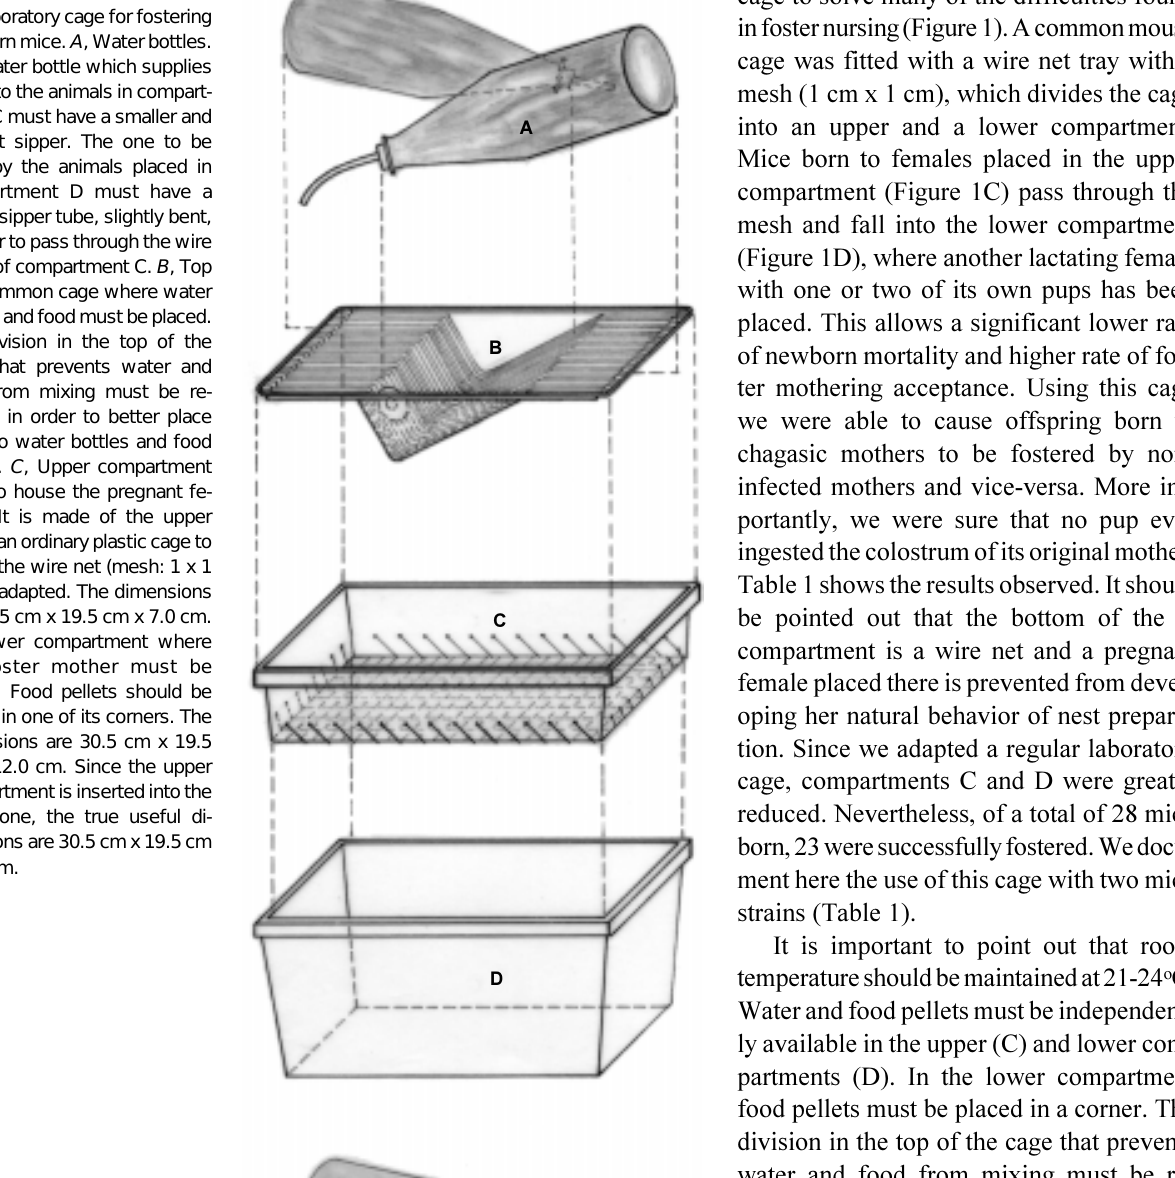
Figure 1 - Schematic illustration of a laboratory cage for